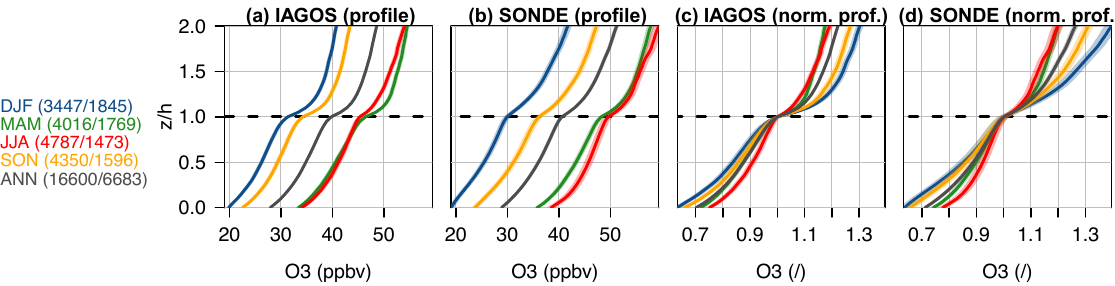
Figure 14. IAGOS and ozonesonde PBL-referenced ( a, b ) and normalized profiles ( c, d ) of O 3 mixing ratios. The number of profiles accounted for is indicated for each season (in brackets: IAGOS / SONDE).